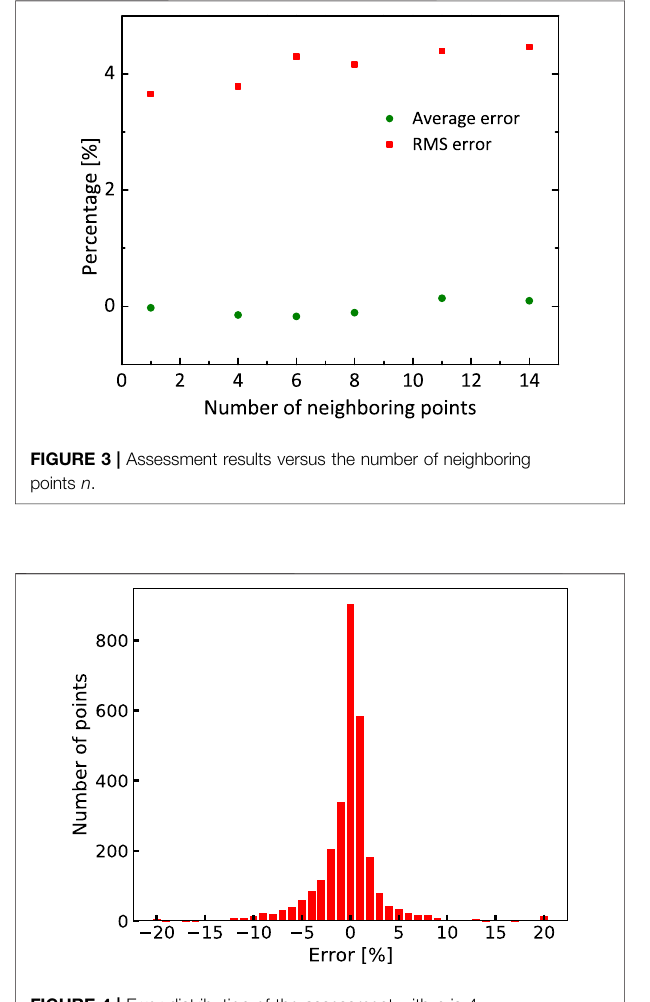
FIGURE 4 | Error distribution of the assessment with n is 4.